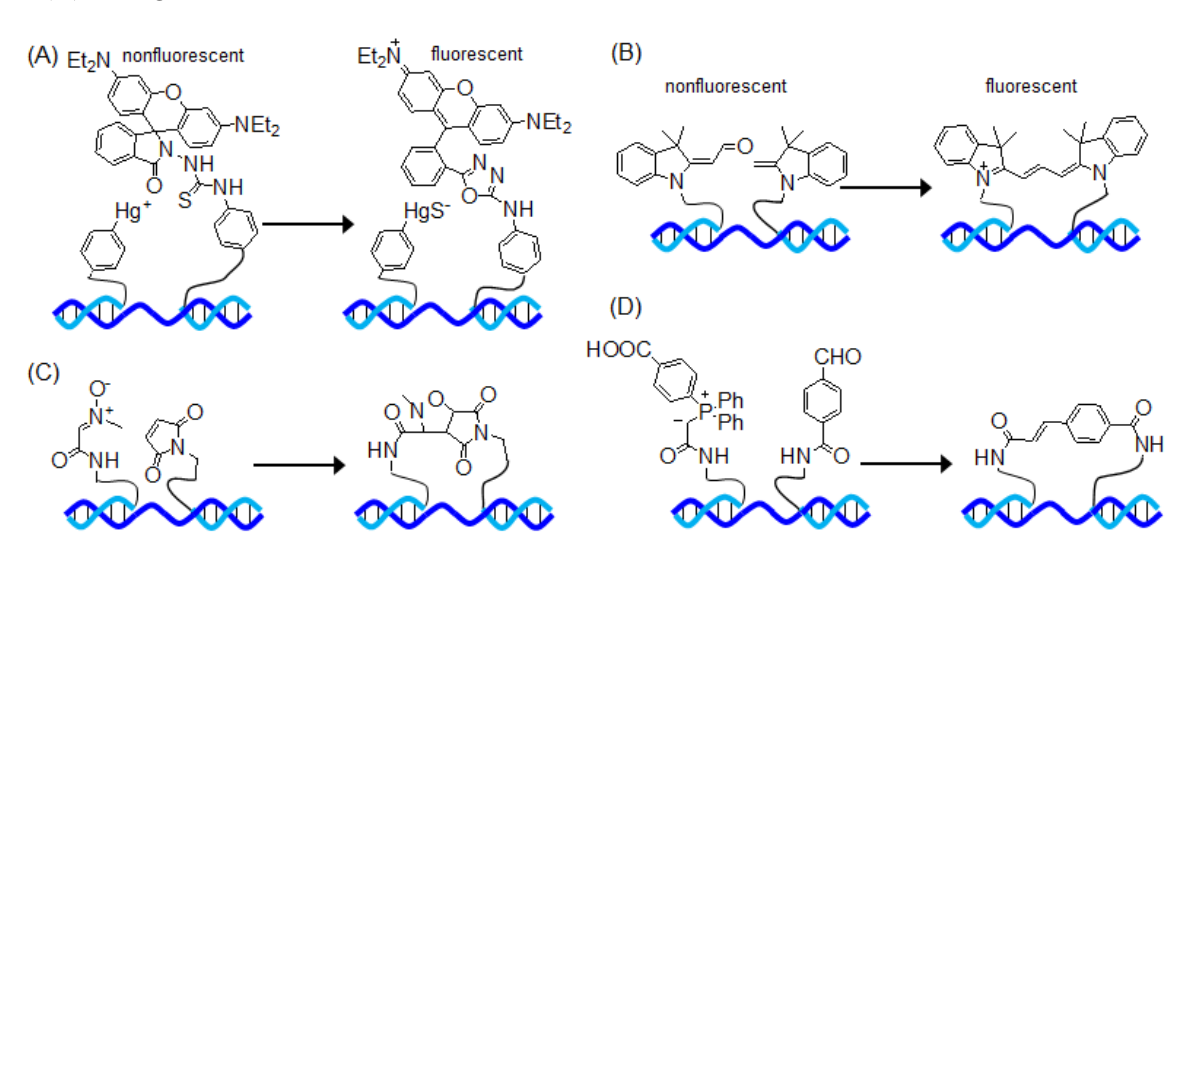
Figure 8. Schematic representation of ( A ) organomercury-promoted oxadiazole forming reaction; ( B ) aldolization-elimination reaction; ( C ) 1,3-dipolar cycloaddition reaction; and ( D ) Wittig olefination